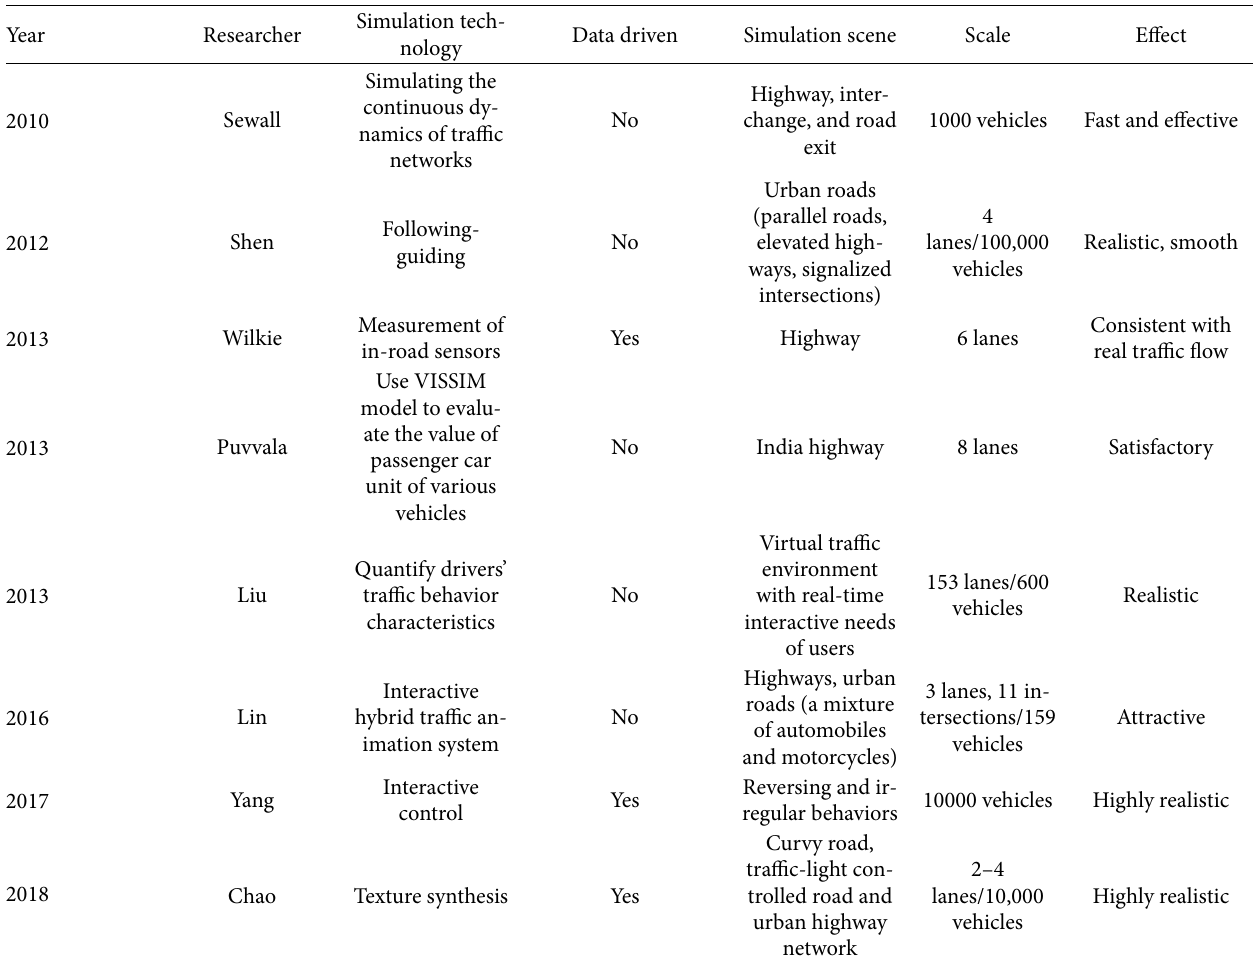
Table 2: Comparison of various vehicle animation